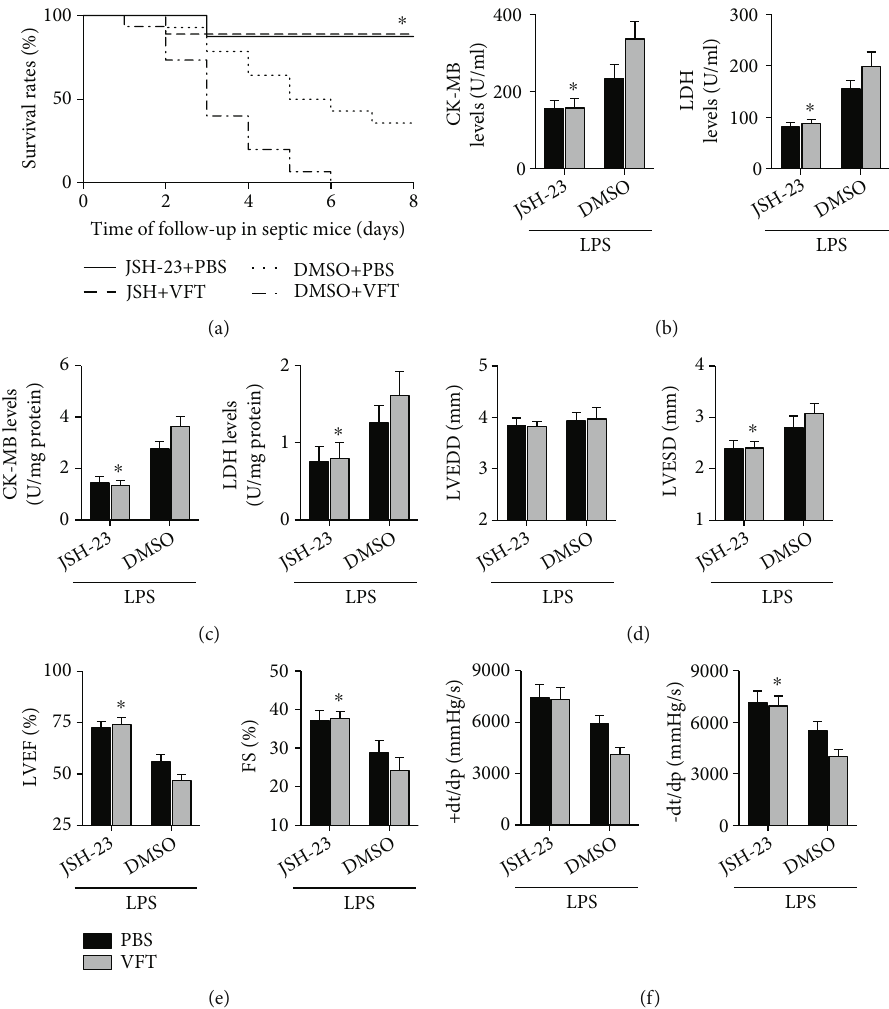
Figure 5: E ff ects of JSH-23 on LPS-induced cardiac injury and dysfunction in mice. (a) The e ff ects of JSH-23 on the survival rates of visfatin-treated septic mice were measured, N = 10 − 15 in each group. (b and c) Cardiac injury markers in the serum and heart were measured. (d – f) Cardiac structure and function in each group were measured. N = 5 − 10 in each group. ∗ p < 0 : 05 vs. the LPS +DMSO +VFT group. VFT means